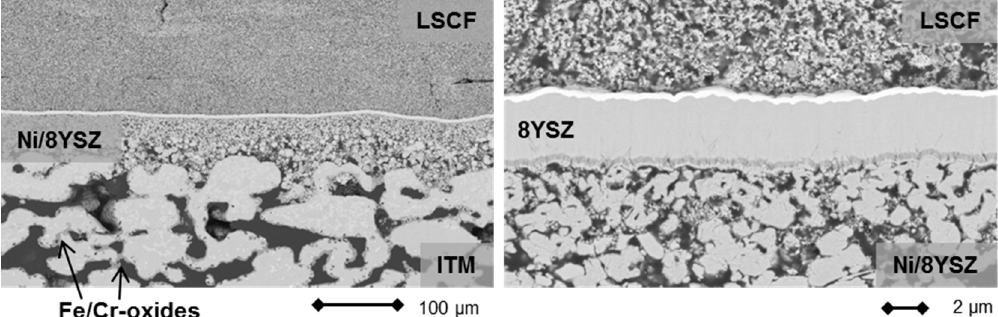
Figure 6. Performance of two MSC cells operated in a stationary stack at 750 °C under galvanostatic conditions (0.5 A/cm 2 ). Materials 2016 , 9 , 762 Figure 7. Cross-section of MSC 2 (see Figure 6) after operation in a stationary design.